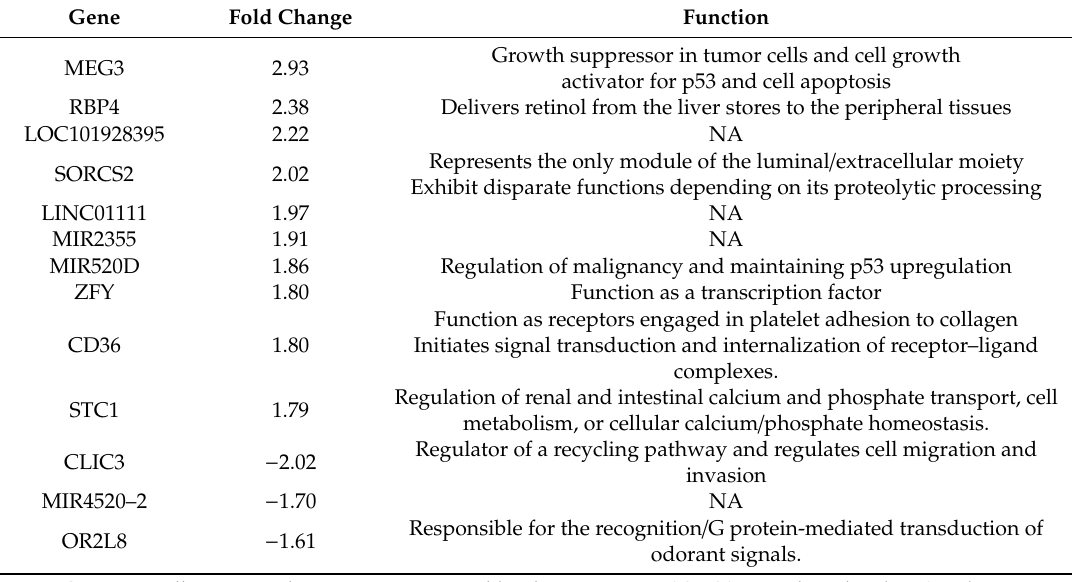
Table 4. Profiling of upregulated or downregulated gene expression in bone marrow-derived mesenchymal stem cells between the non-responder and responder